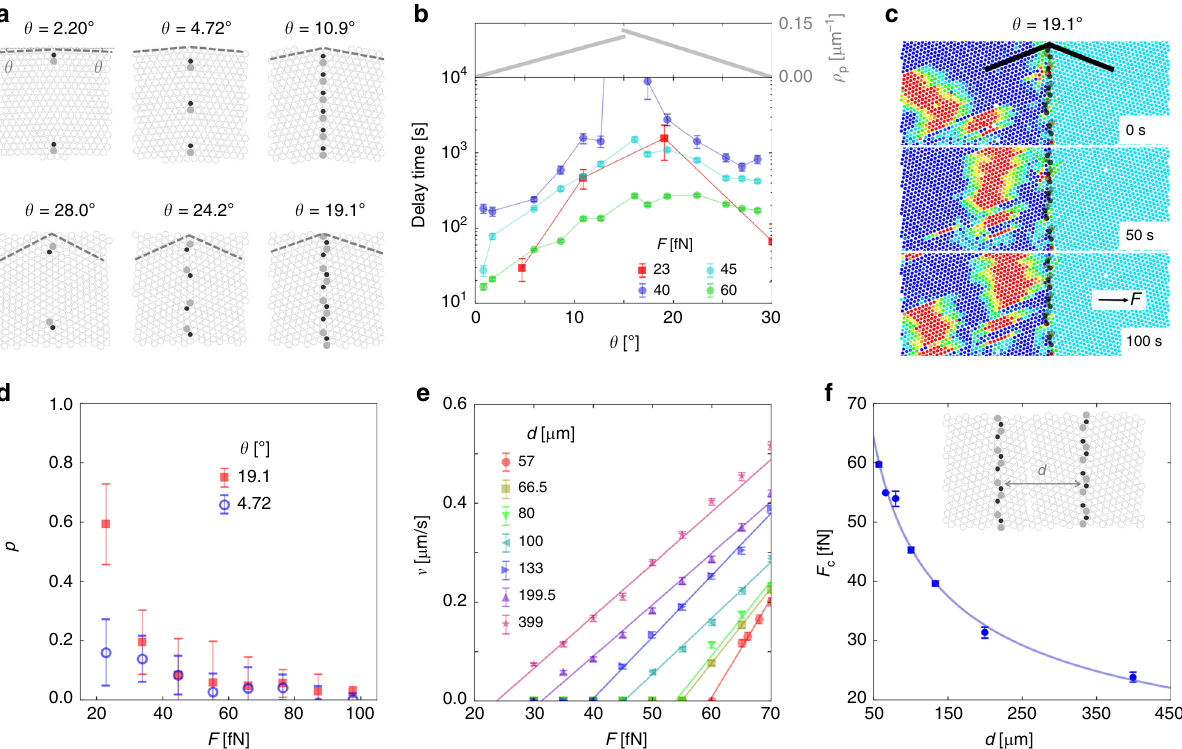
Fig. 3 Interstitial pile-up at GBs with large misalignment angles. a The structure of GBs at various values of θ = θ 1 = θ 2 . The 5 – 7 pairs are highlighted as shaded regions. b (bottom) The average delay time as a function of θ in experiments (squares) and simulations (circles) at different driving force F . (top) The density of 5 – 7 pairs, Eq. (1). c The pile-up of broad interstitials at the θ = 19.1° GB in experiment. F = 23 fN. The particle color code and the highlight of 5 – 7 pairs at the GB are as in Fig. 2a. d The pile-up ratio p as a function of driving force F at θ = 19.1° and θ = 4.72°. e The average interstitial velocity v as a function of the driving force F at various grain sizes d in simulation. All GBs are symmetric with θ = 19.1° as illustrated in ( f ) inset. Lines are linear fi ttings v = μ ( F – F F d . Solid line represents F = F + k / d 1/2 with fi tted F = 1 ± 2 c ) of the corresponding data points. f The critical force c as a function of grain size c 0 0 fN and k = 450 ± 20 μ m 0.5 . (inset) Illustration of a polycrystal with grain size d . All error bars are standard deviations of the corresponding data